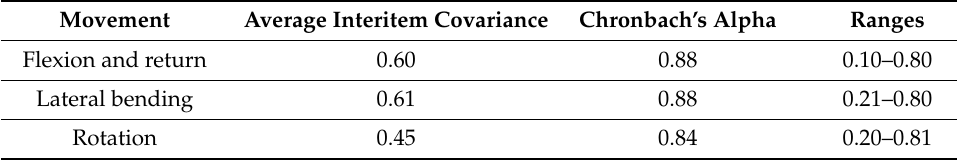
Table 3. Internal consistency (Chronbach’s Alpha).